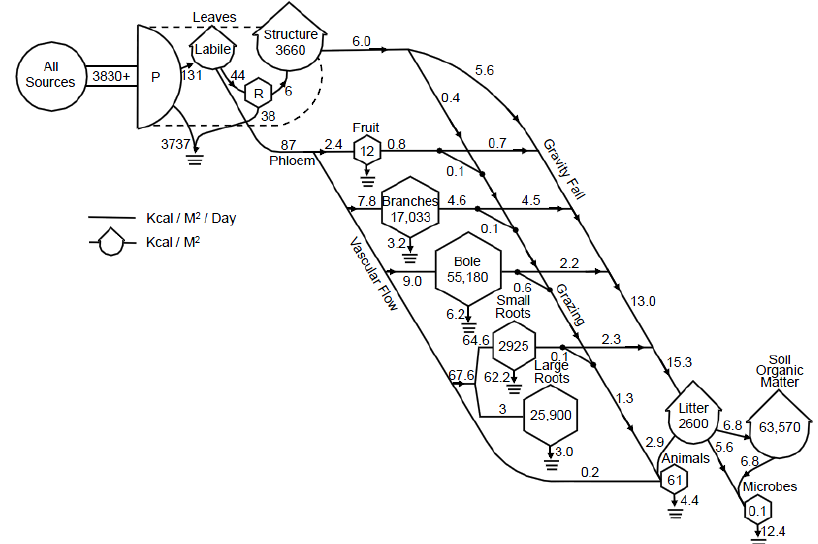
Figure 1. Carbon budget of a subtropical wet forest at El Verde, Puerto Rico [10] expressed in energy units (about 4 kcalories per g of vegetation material, because Odum used caloric equivalents of the various materials). The budget was constructed assuming steady state for the whole system. However, plants do exhibit greater production than respiration. Photosynthesis is P, R is respiration, structure refers to leaf biomass, and the symbols are those of the energy language of Odum [10]: bullet symbol represents photosynthesis, hexagons are consumer compartments, tanks are storages, the circle represents external energy inputs, the heat sinks are energy losses as a result of energy transformations, and lines represent the